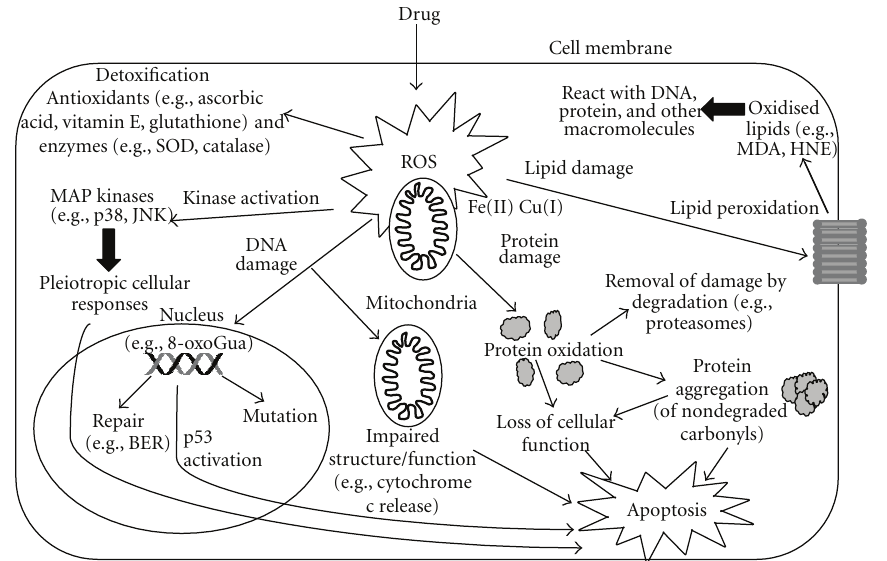
Figure 2: The main e ff ects of drug-induced oxidative stress in cells. Increases in intracellular ROS may result in DNA damage, oxidation of lipids and proteins. MAP kinase signaling pathways are key mediators of the cellular response.